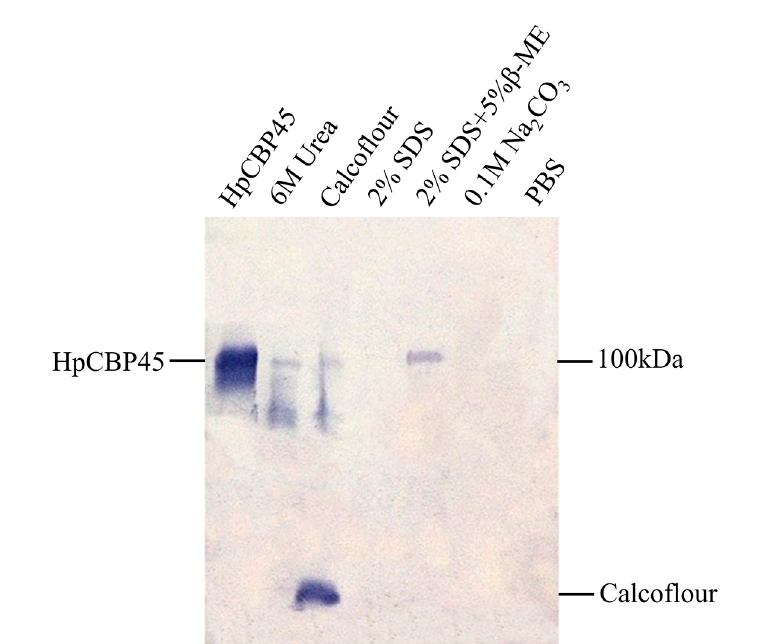
Figure 5. Western blot analysis for chitin binding activity of recombinant